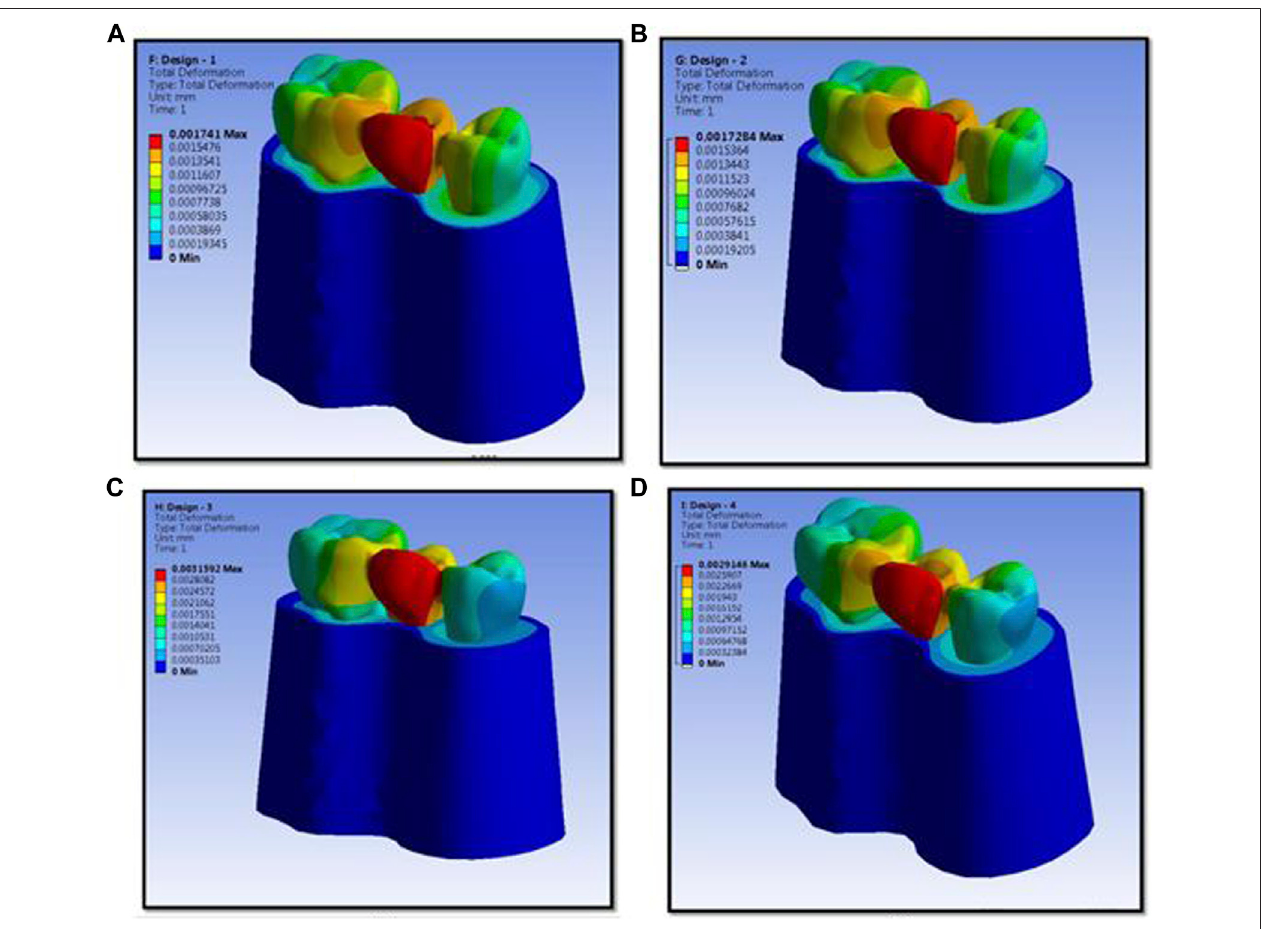
FIGURE 9 | Maximum deformation observed in prosthesis and the magnitude for design 1 (A) , design 2 (B) , design 3 (C) , and design 4 (D) used in fi nite element analysis.